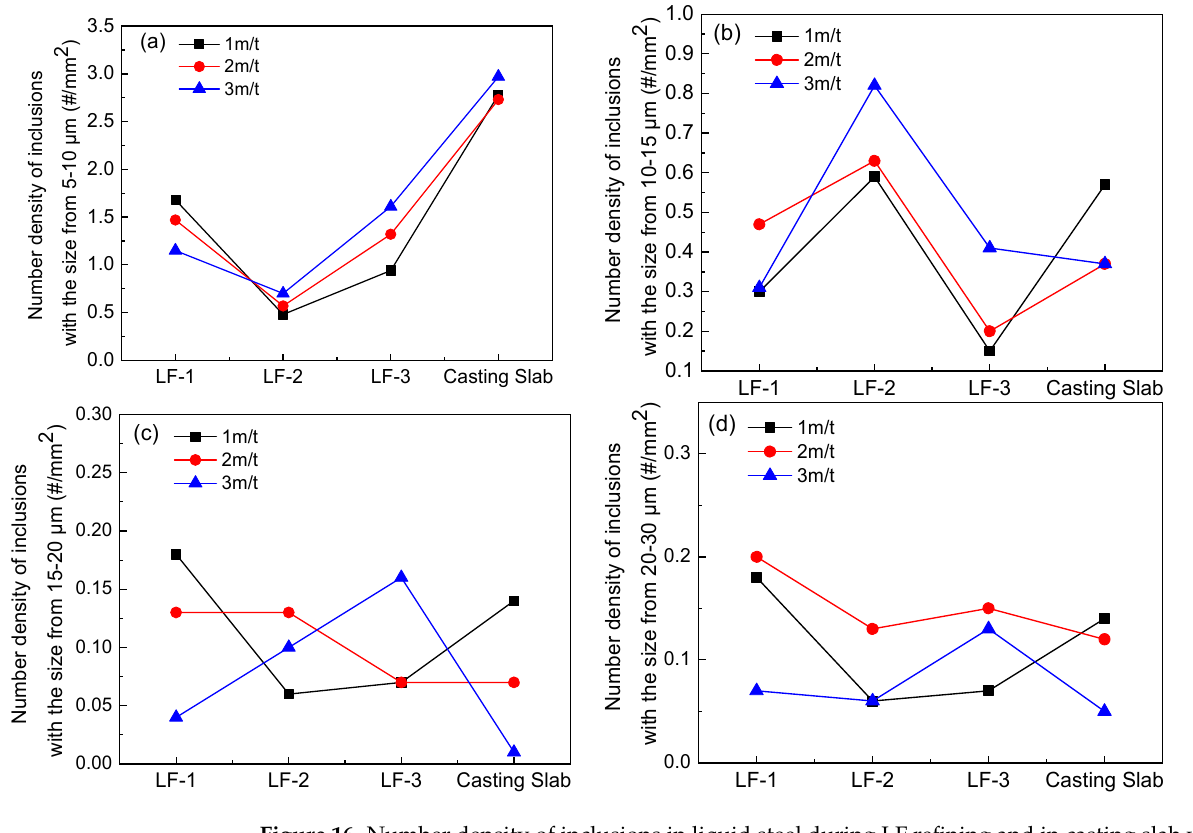
Figure 16. Number density of inclusions in liquid steel during LF refining and in casting slab when different Si-Ca addition amount is used in LF. Note: LF-1, LF-2, and LF-3 represent beginning of LF, before calcium addition at LF, and end of LF refining, respectively. ( a ) 5-10 μ m, ( b ) 10-15 μ m, ( c ) 15-20 μ m, ( d ) 20-30 μ m.